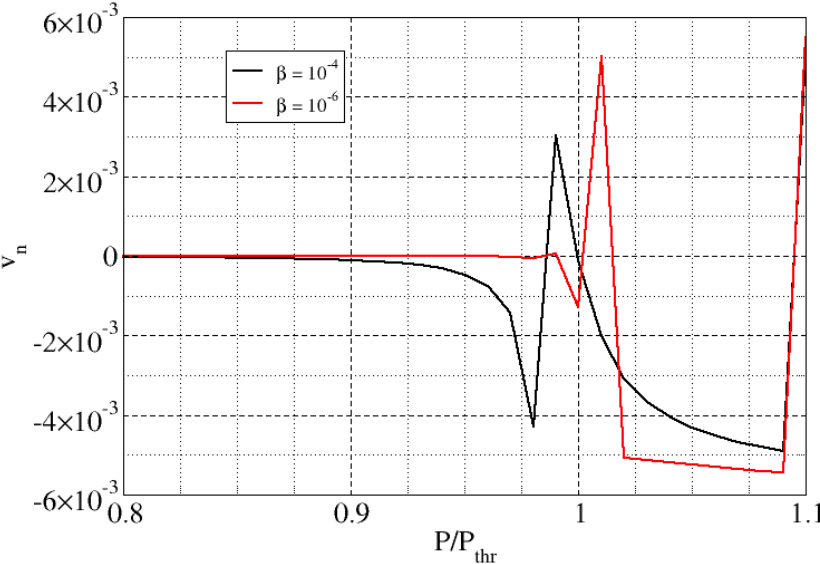
Figure 8. Comparison of the photon component v n of the least stable eigenvector (matching the least stable eigenvalue in Figure 4) for a micro- ( β = 10 − 4 ) and a macroscopic laser ( β = 10 − 6 ). As in Figure 7, each curve stops at the point where the eigenvector becomes complex, simultaneously with the appearance of an imaginary component in the corresponding eigenvalue.